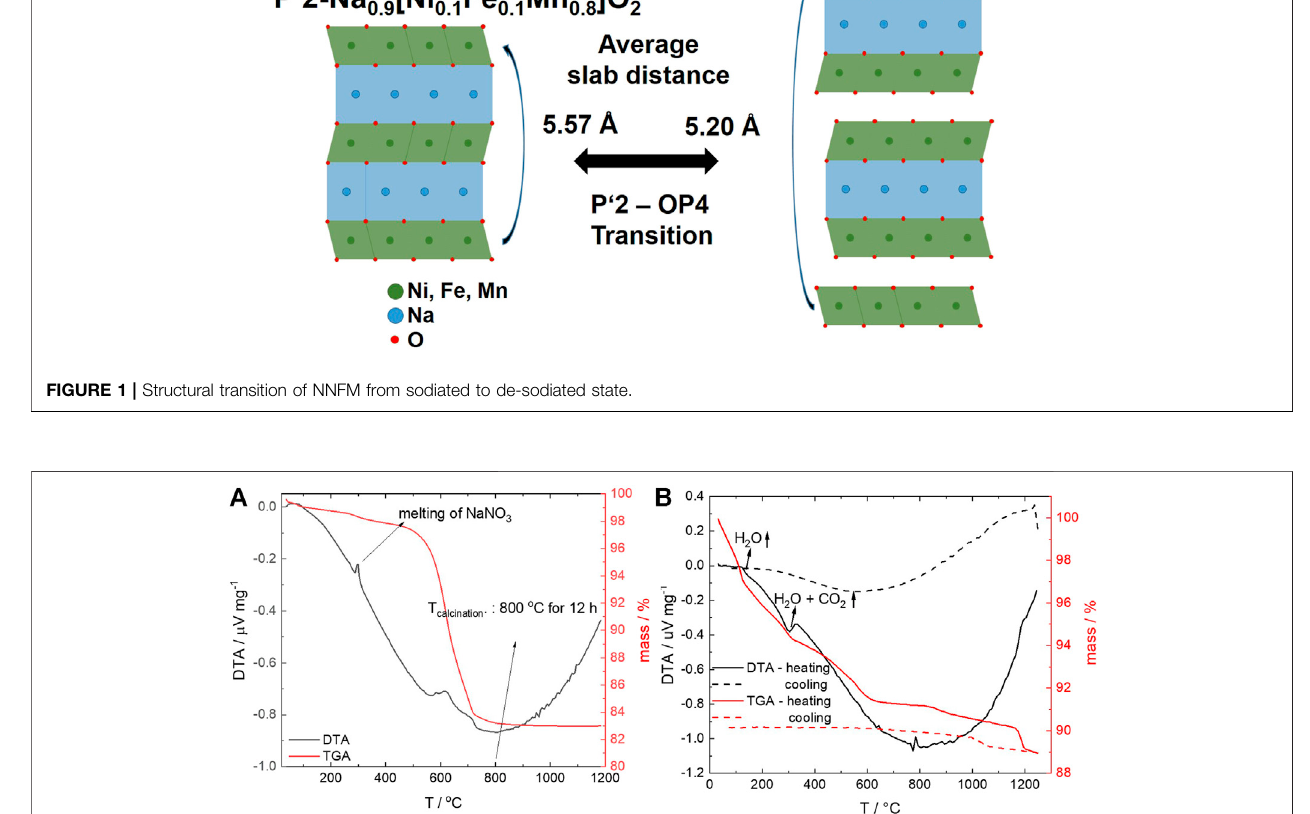
Frontiers in Energy Research |